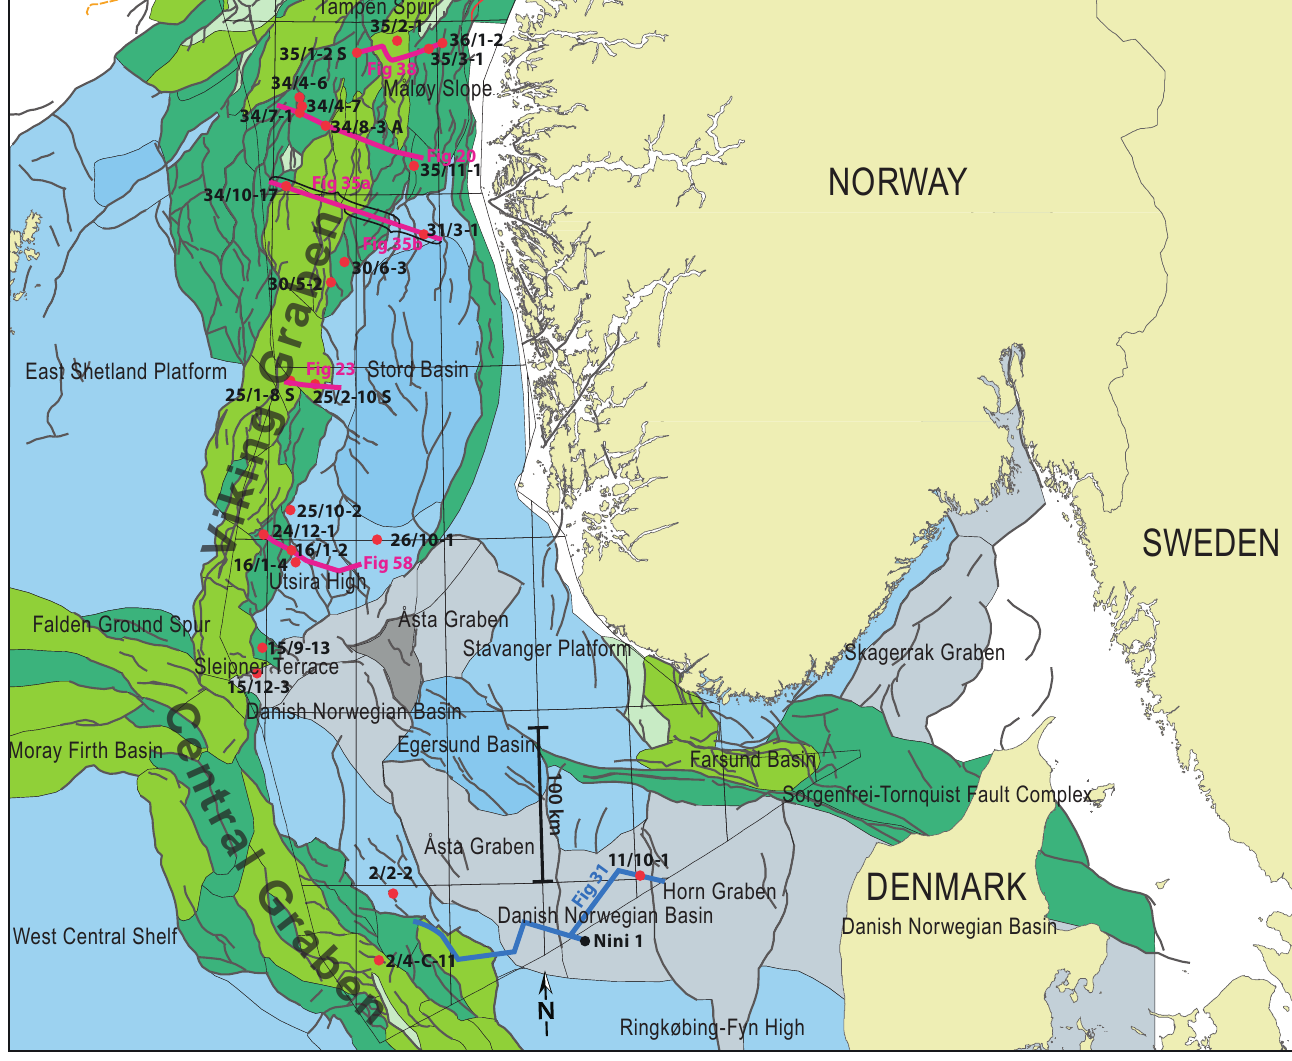
Figure 5. Map showing structural elements and seismic lines in the North Sea and the Norwegian–Danish Basin. Red dots are investigated wells and boreholes, black dots are other important wells or boreholes. The map is according to the NPD factpages (npd.no/facts), also modified after Eidvin et al. (2013d, 2014) (see npd.no/ facts for color